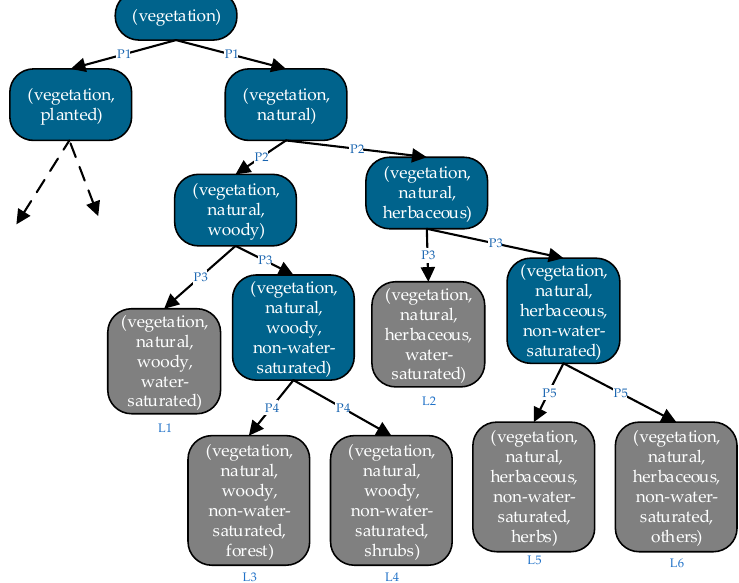
Figure 4. Integrated representative semantic features based on the dynamic semantic reference system (DSRS): example of vegetation classes.